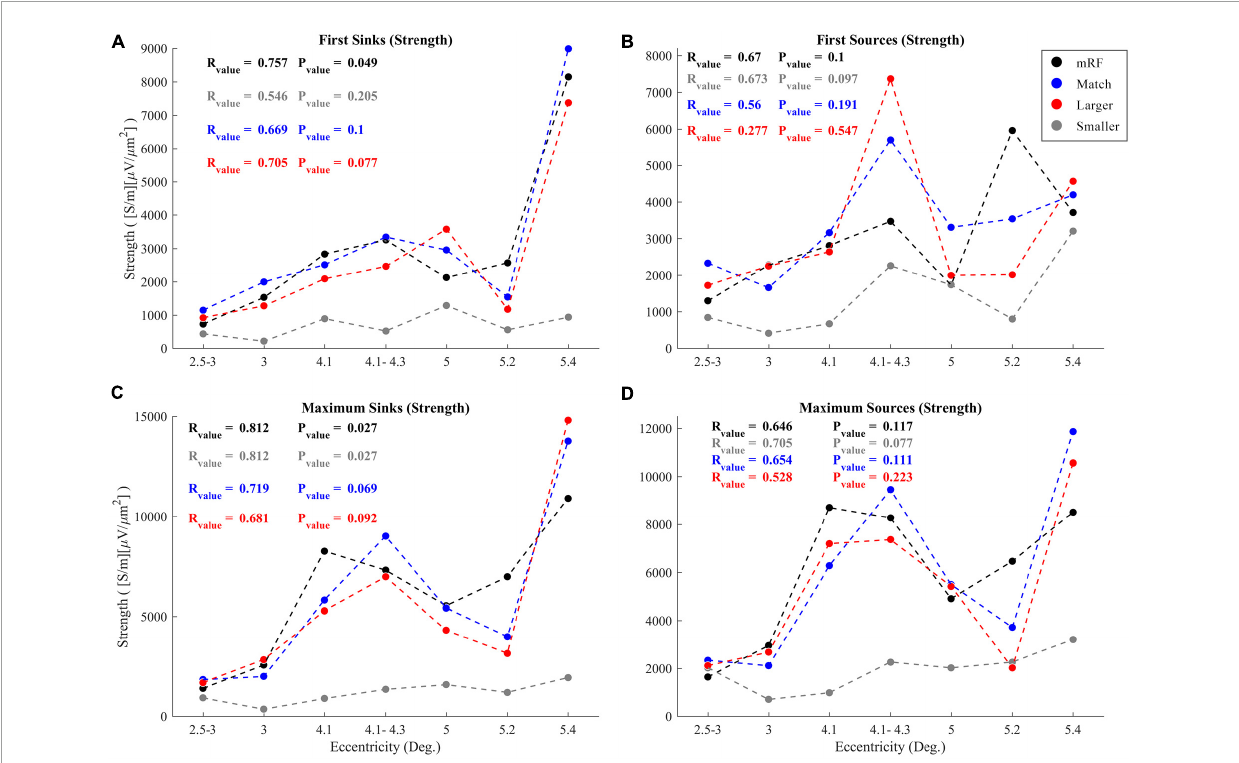
FIGURE11 Value of first sinks (A) and sources (B) in current sinks and sources (CSD) profile in response to black square stimulus (black), equal stimulus size with RF (blue), larger (red), and smaller (gray) than RF with increasing eccentricities. The (C) and (D) graphs show values of maximum sinks and sources. The R and P -values corresponding to the correlation coefficients of all four types of stimuli are written with the legend colors. The horizontal and vertical axes indicate eccentricity and strength of sinks and sources,